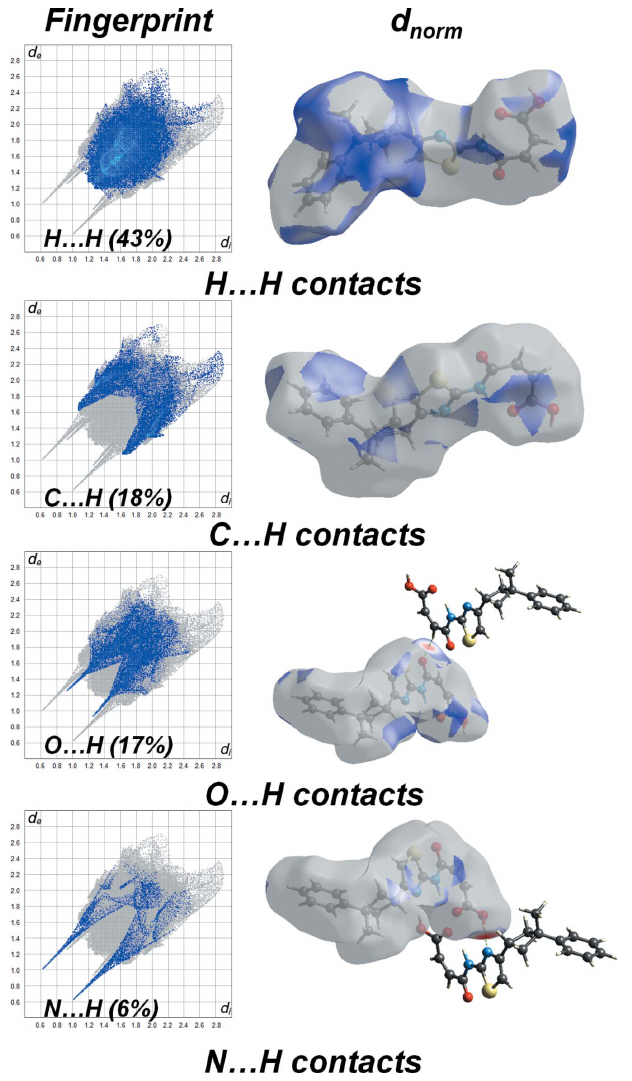
Figure 3 The Hirshfeld surface analysis of the title compound mapped with d norm over the range (cid:5) 0.763 to 1.558 showing C—H (cid:2)(cid:2)(cid:2) O and O—H (cid:2)(cid:2)(cid:2) N hydrogen-bonded contacts.